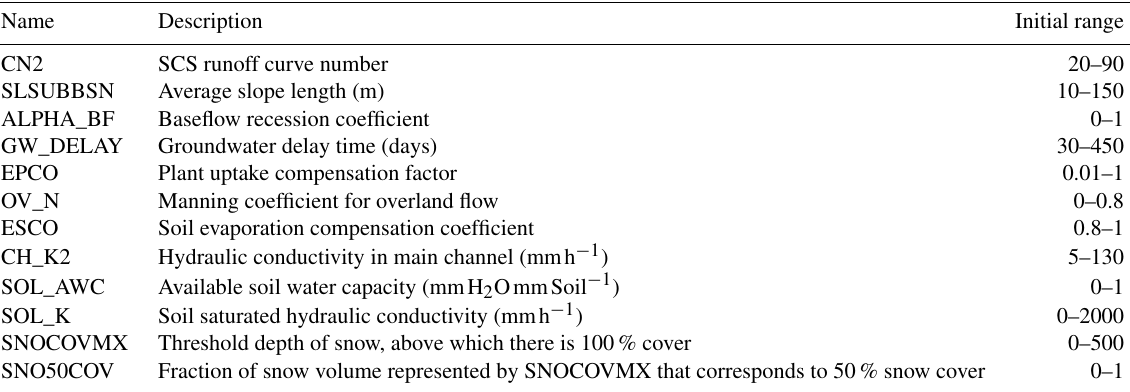
Table 2. SWAT model parameters calibrated.